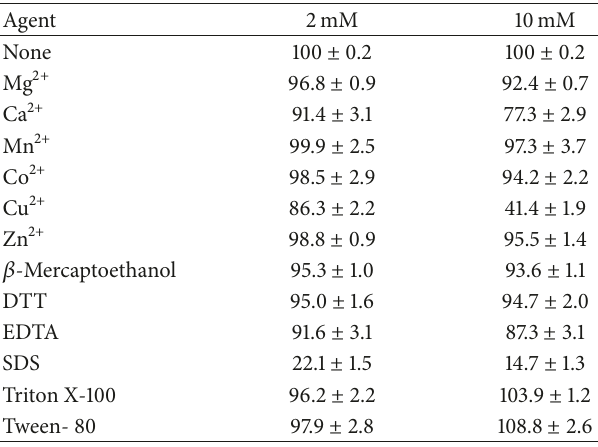
Table 2: Effect of metal ions, reducing agents, and ionic and nonionic surfactants on XynA MG 1 xylanase